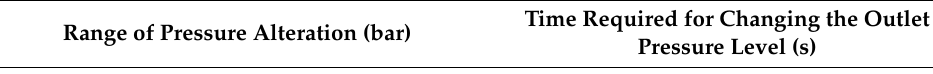
Table 2. Time required for compressed air pressure regulation depending on the operating pres- sure value.